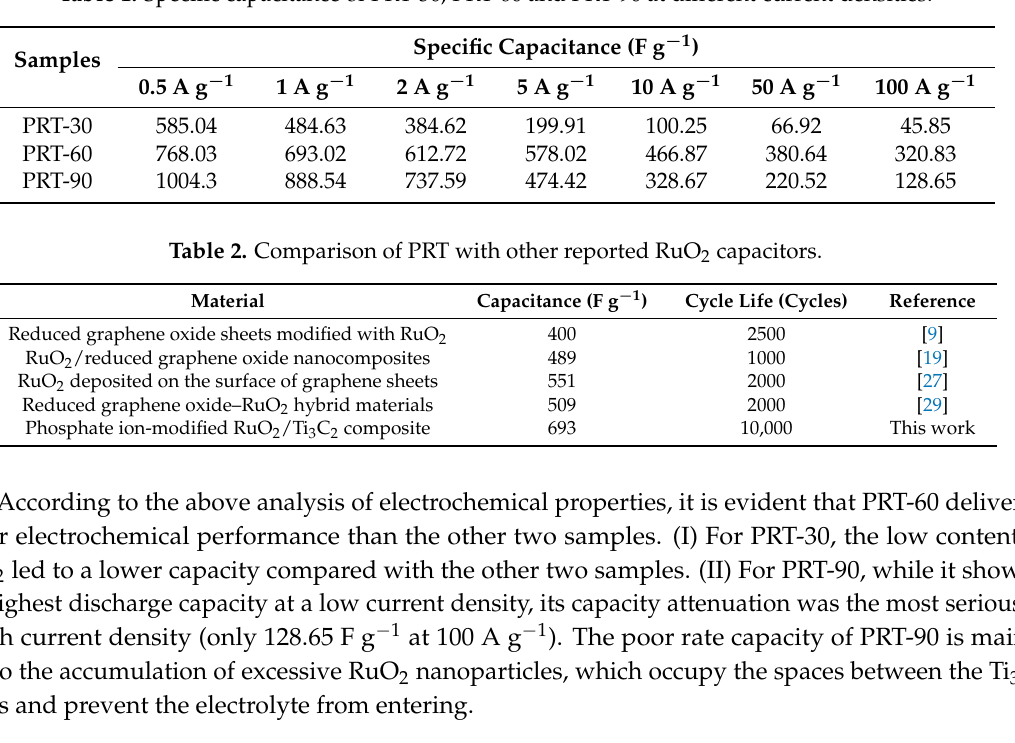
Table 1. Specific capacitance of PRT-30, PRT-60 and PRT-90 at different current densities.